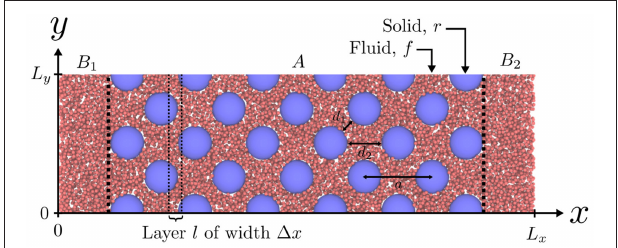
FIGURE 2 | A slice of the simulation box in case II. The box has side lengths L x , L y , L z , and properties are calculated along the x -axis in layers l of width 1 x . Blue particles are grain r and red particles are fluid f . The A is the lattice constant of the fcc lattice, d 1 and d 2 are the two shortest surface-to-surface